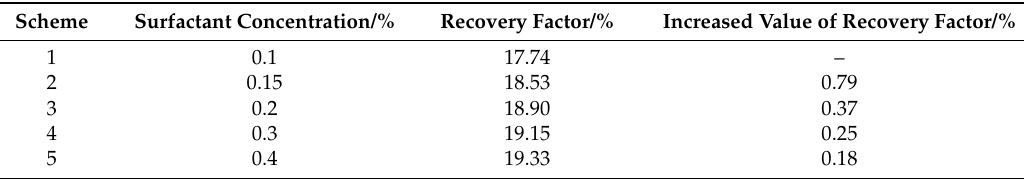
Table 4. Recovery factor percentage of different experimental schemes.